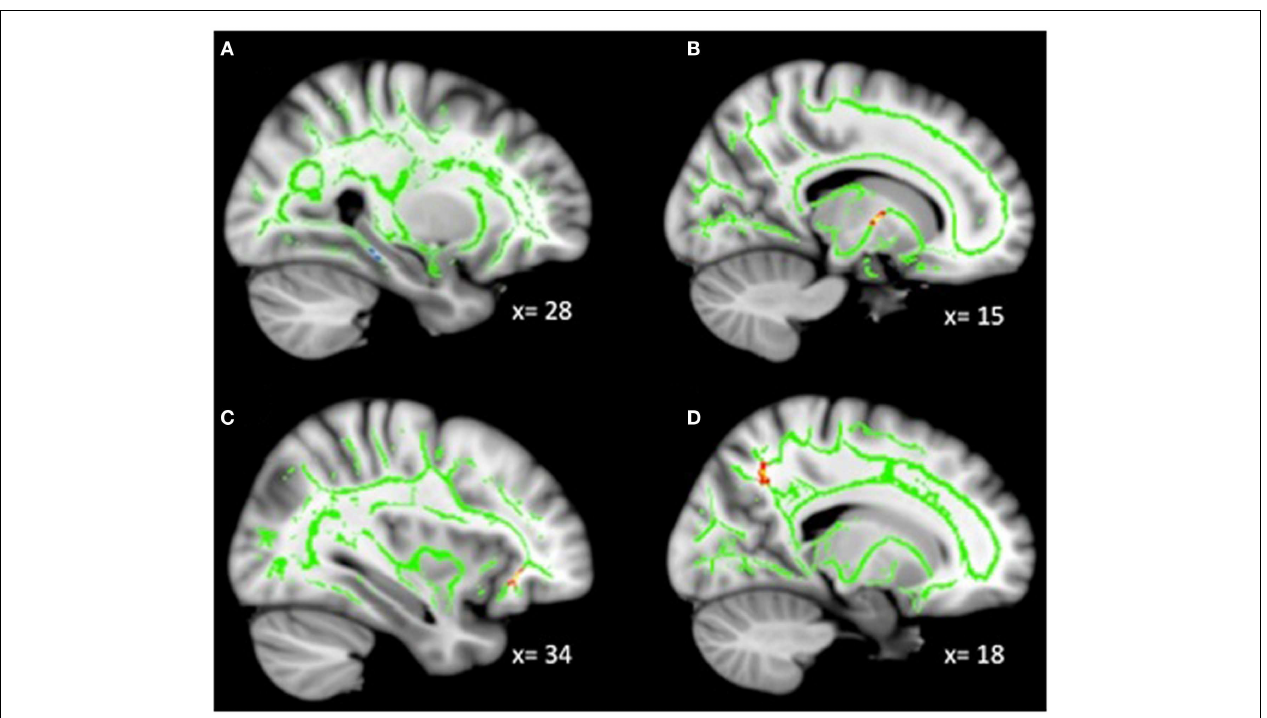
FIGURE 3 | (A) IncreasedWM integrity as anhedonia increased in the posterior cingulum near the hippocampus; decreasedWM integrity as anhedonia increased in the (B) anterior limb of the internal capsule; (C) IFOF near the OFC; (D) posterior cingulum near the precuneus. Key: IFOF, inferior-fronto-occipital fasciculus; OFC, orbitofrontal